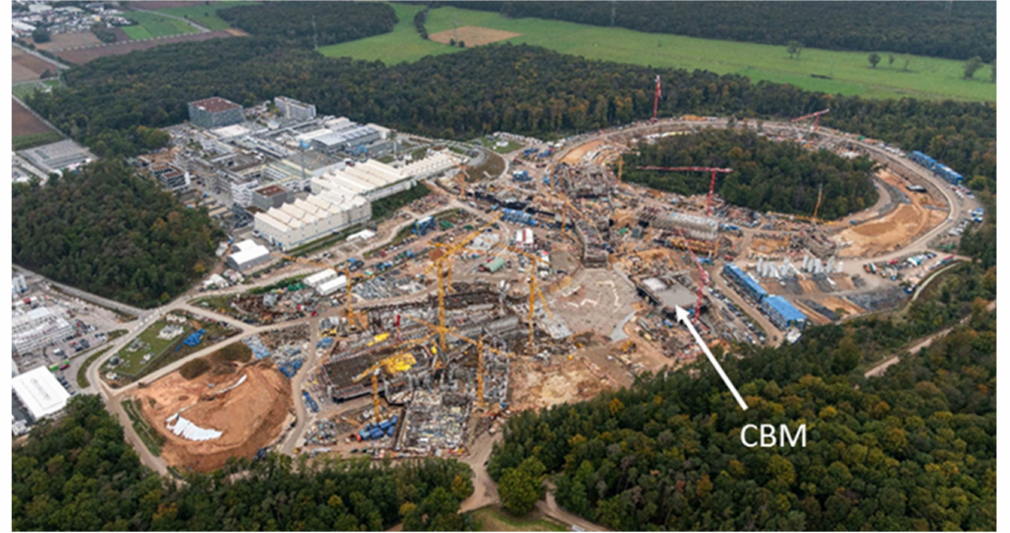
Figure 5. Photograph of the FAIR construction site, September 2021 [49]. The underground syn- chrotron tunnel building is already covered with soil. Furthermore, the shell construction of the CBM cave is